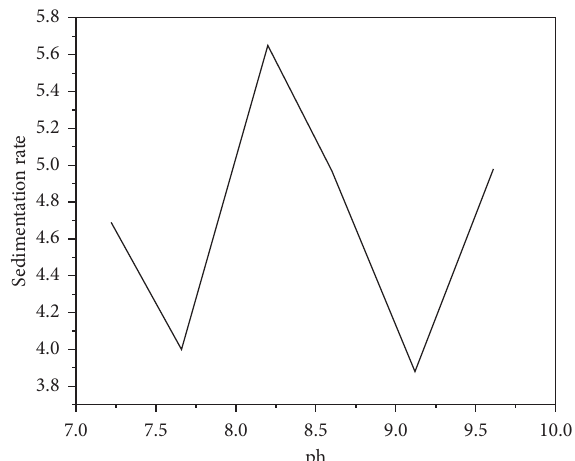
Figure 4: Relationship between sedimentation rate and mass fraction of dispersant.